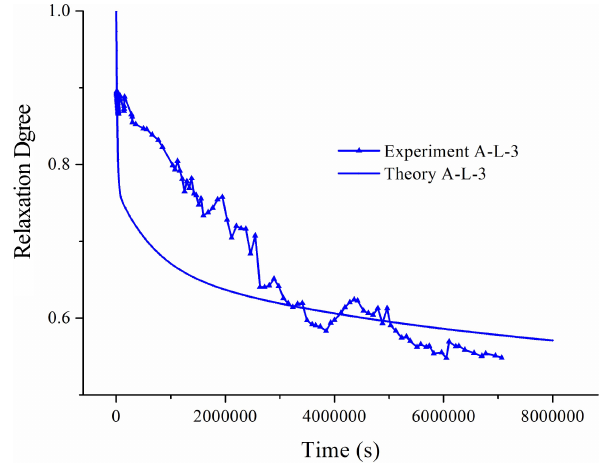
Figure 11: Comparison of preload relaxation for A-L-3